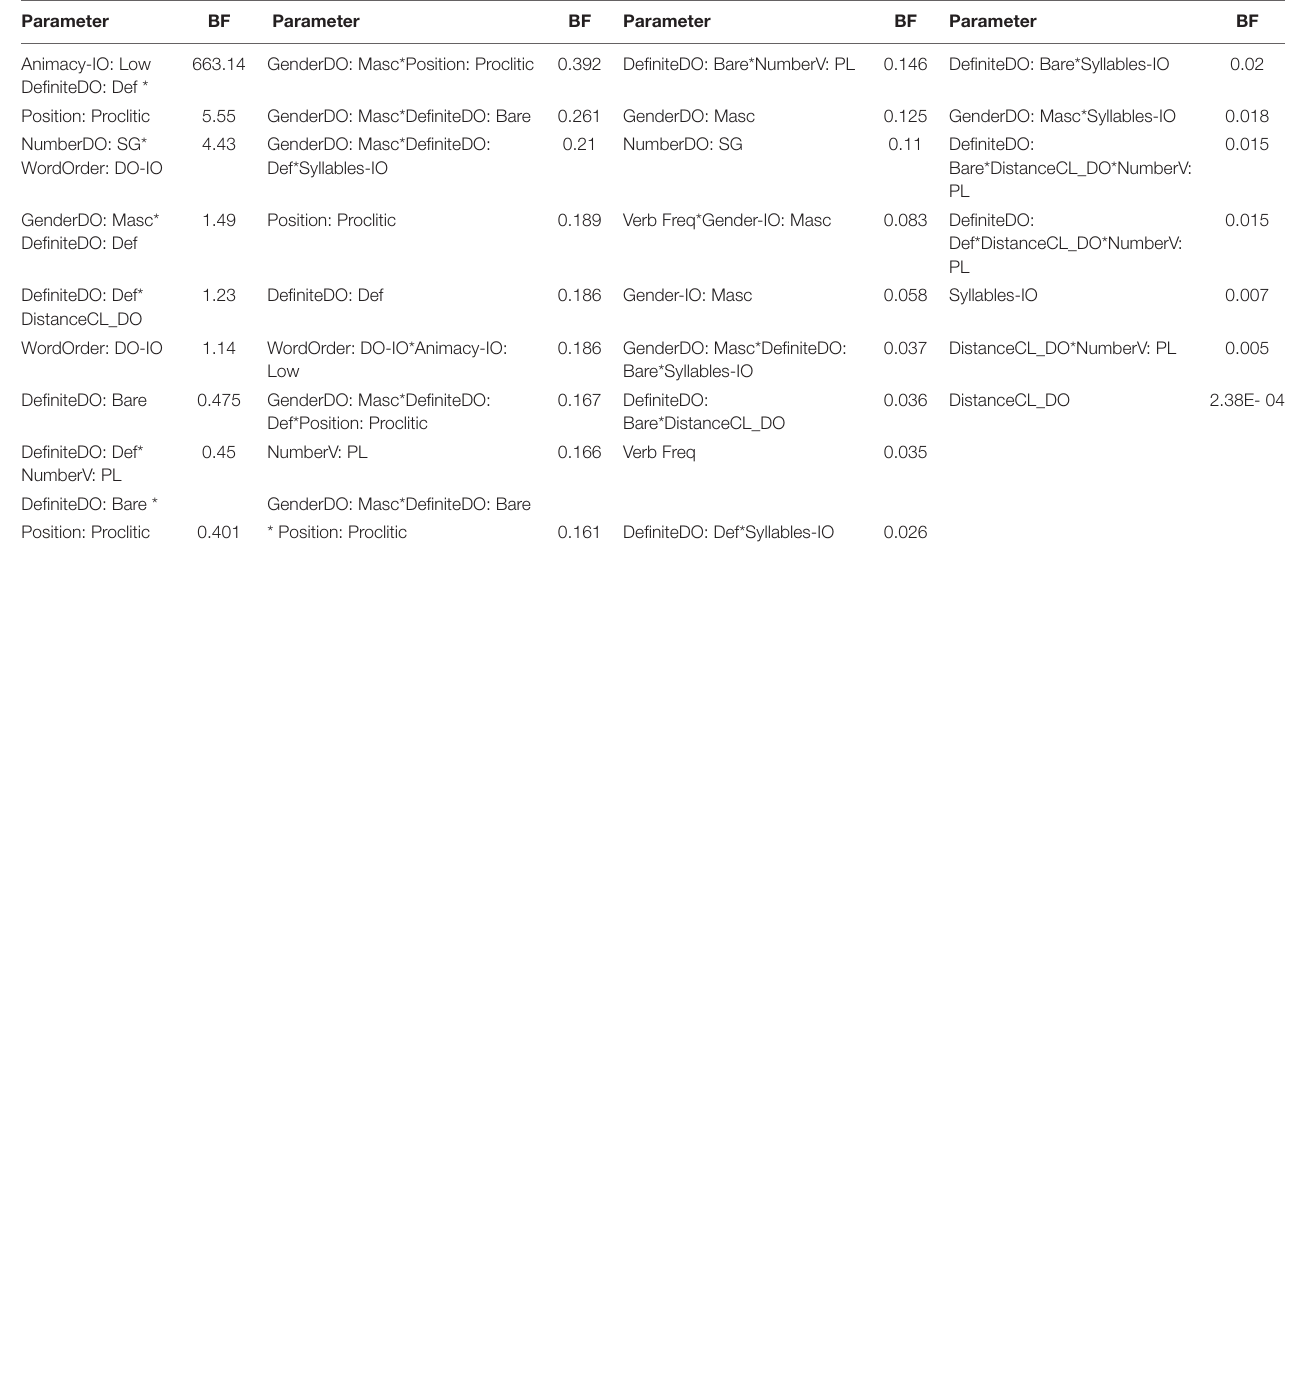
TABLE A1 | Bayes factors of full